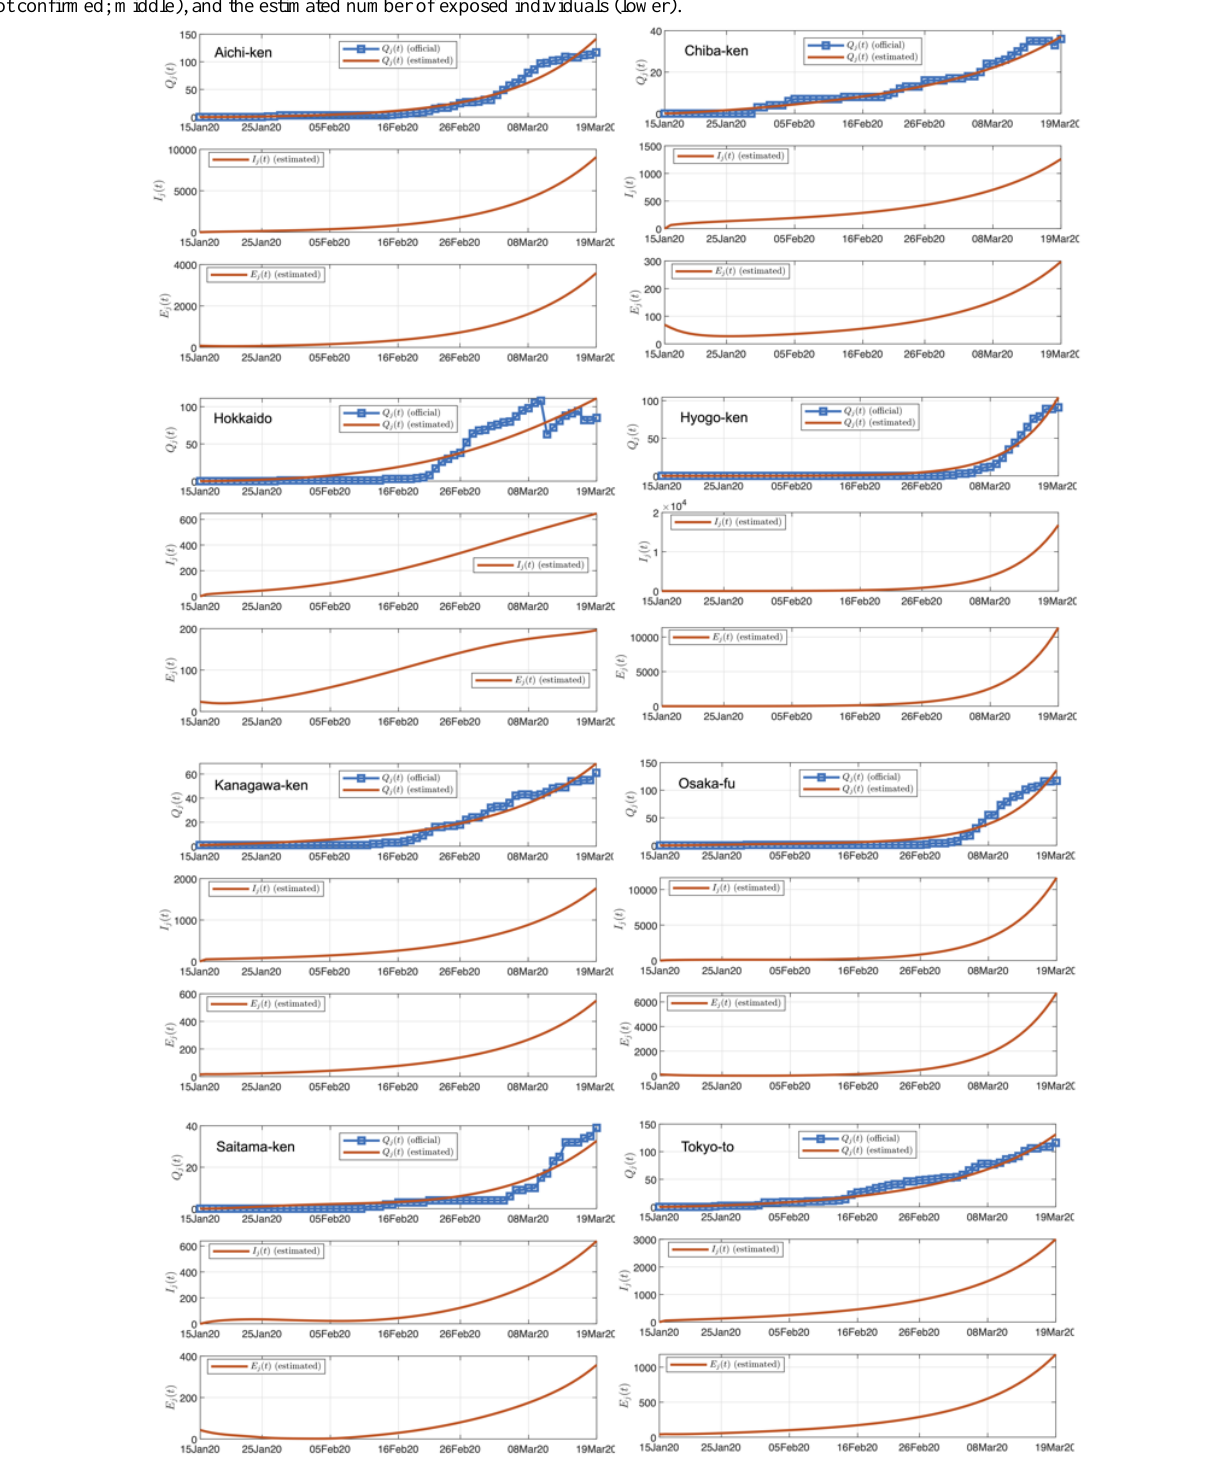
Figure 2. Official and estimated number of infected individuals in 8 selected prefectures in Japan (upper), the estimated number of infected individuals (not confirmed; middle), and the estimated number of exposed individuals